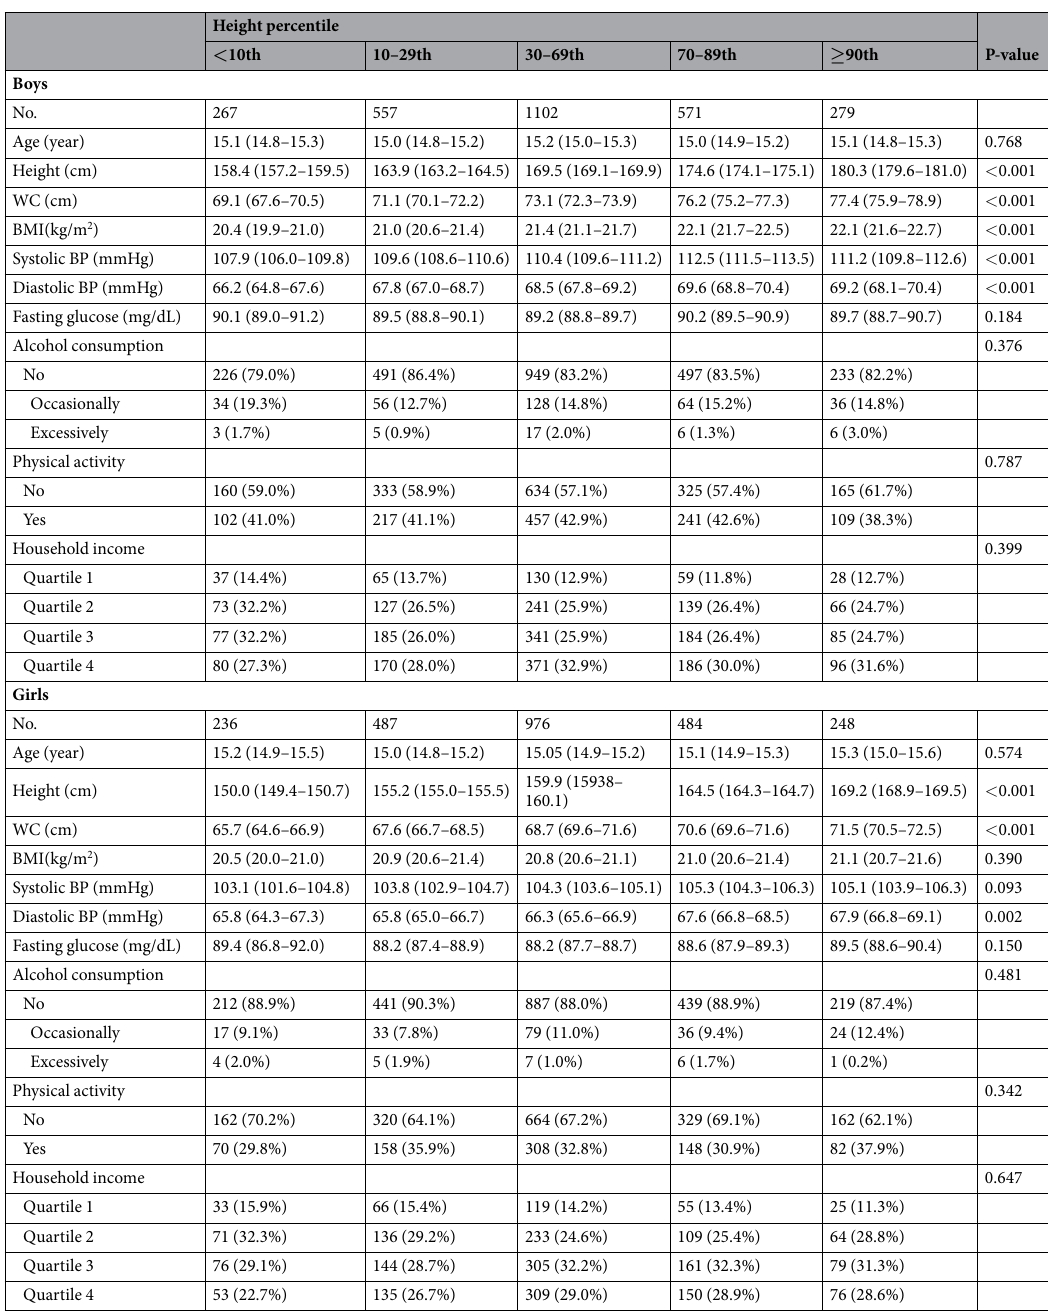
Table 1. General characteristics of the subjects according to the height percentile in 5,207 adolescents. The data were present as mean (95% confidence interval) or number (%). BMI, body mass index; BP, blood pressure; WC, waist